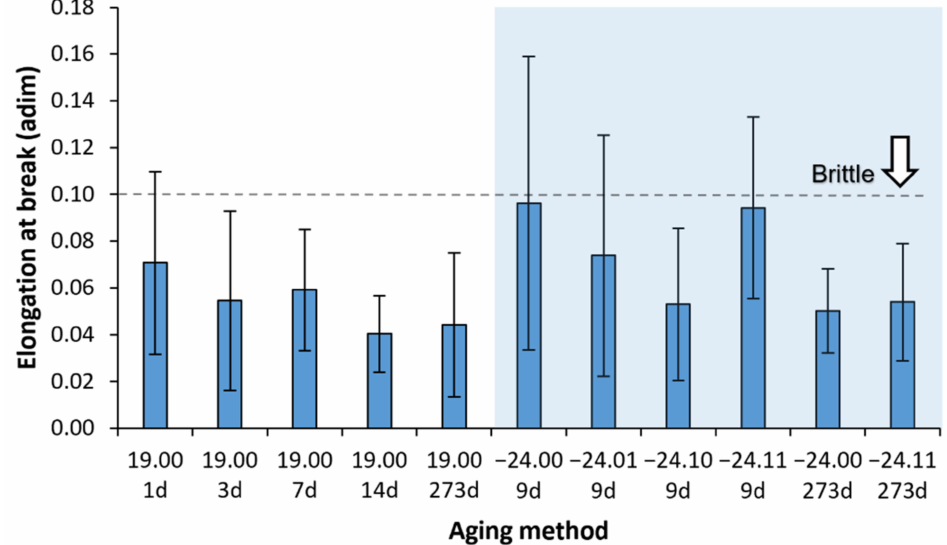
Figure 13. A bar diagram with the average elongation at break with its mean square error versus the ageing time. The shadow area shows the frozen sample value interval. Six samples were measured for each ageing conditions and error bars are the standard